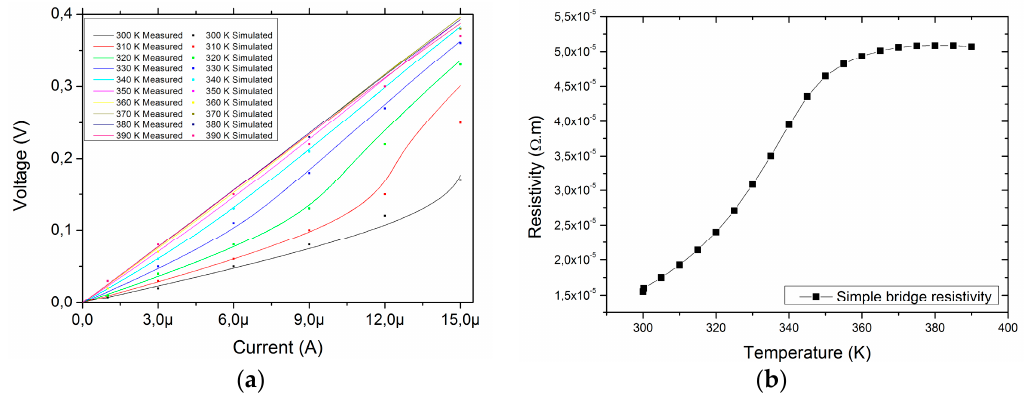
Figure 1. ( a ) Electrical resistivity versus temperature in the 300–390 K range at I = 0 A; ( b ) Measured and simulated simple bolometer voltage versus current for temperatures in the 300–390 K range.